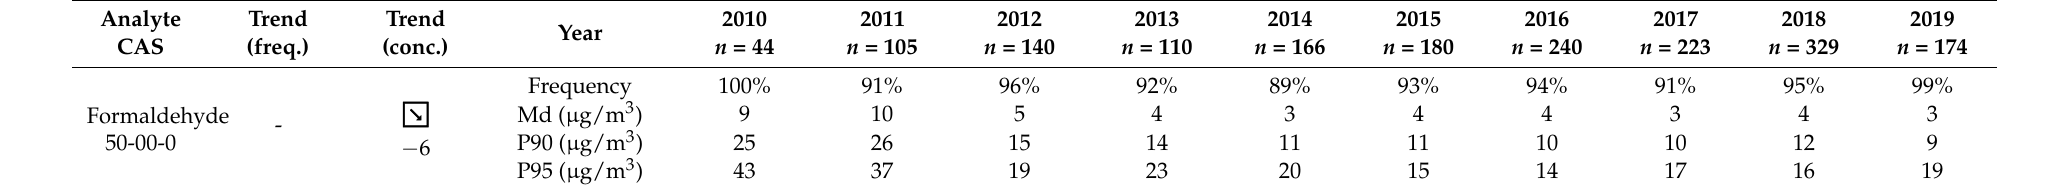
Table 4. Annual statistics of VOCs (a) and formaldehyde (b) during the ten-year study period 2010–2019. Frequency trend was tested using Somer’s D test, where input data were binomial (measurement result either >LOQ or <LOQ). Concentration trend was tested using Somer’s D test, where input data comprised all measured concentration values. Here, measurement results that were <LOQ were replaced by a concentration value LOQ/2. Trends indicated by downward or upward arrow symbol were statistically significant ( p < 0.0001) and had ǀ Z ǀ ≥ 4. Z values shown below arrow symbols indicate direction and steepness of